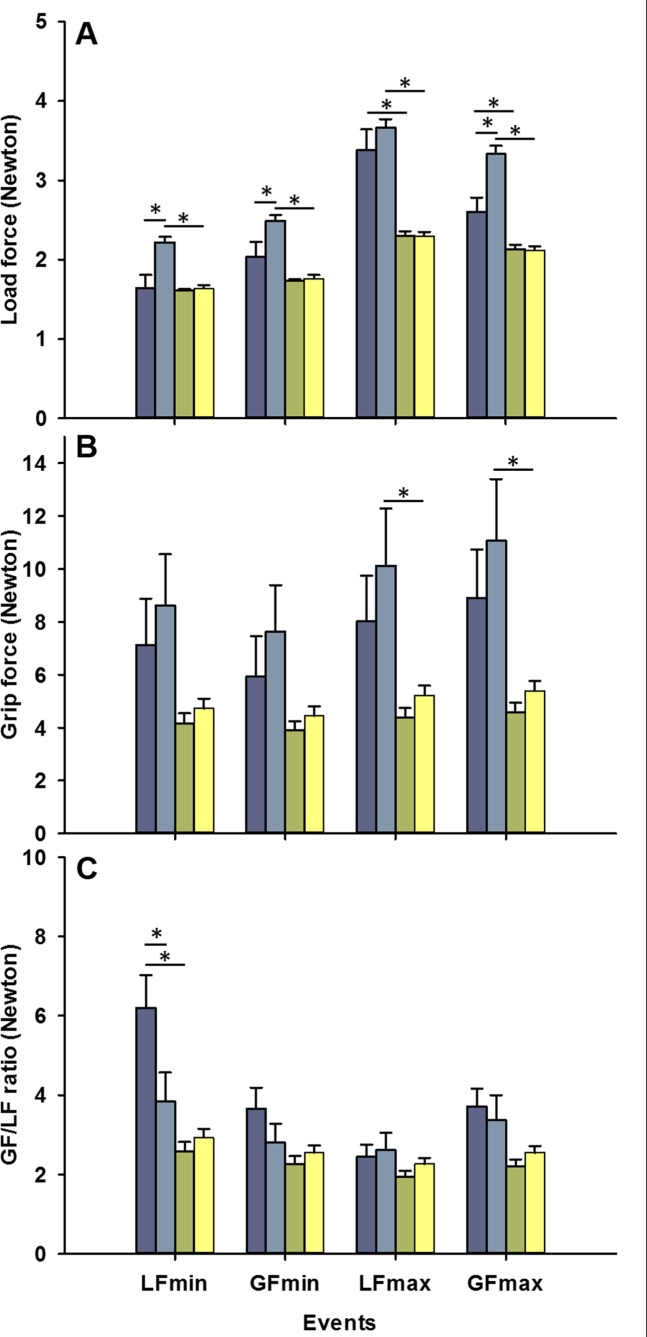
Results of dynamic variables in function of the events (LFmin, GFmin, LFmax and GFmax).A) Mean Load force. B) Mean Grip force. C) Mean GF/LF ratio. The four conditions are presented in colour code as follow: blue = more affected hand, cyan = less affected hand, green = nondominant hand and yellow = dominant hand. Error bars represent the standard error. * indicates p-value <0.050.